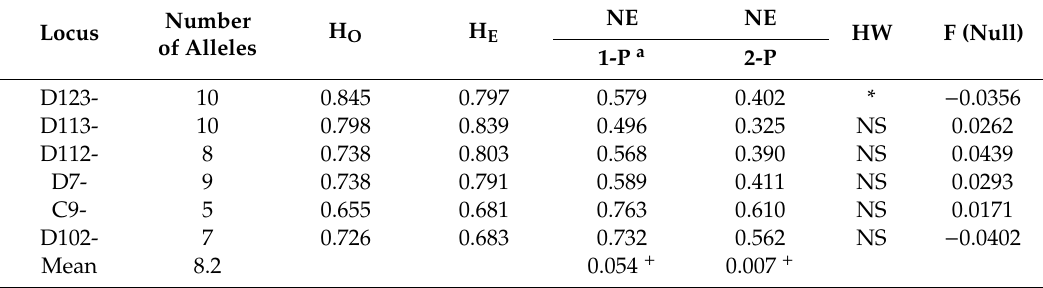
Table 2. Microsatellite marker polymorphism in Abudefduf sordidus, based on alelles in 74 adult females (reconstructed genotypes) and 10 adult males. Number of alleles, observed ( H O ) and expected ( H E ) heterozygosities, non-exclusion (NE) probabilities (under the ‘one parent known’ or ‘two parent known’ models), results of the goodness-of-fit Hardy–Weinberg (HW) equilibrium test, and null allele frequency based on heterozygote deficit are shown for each